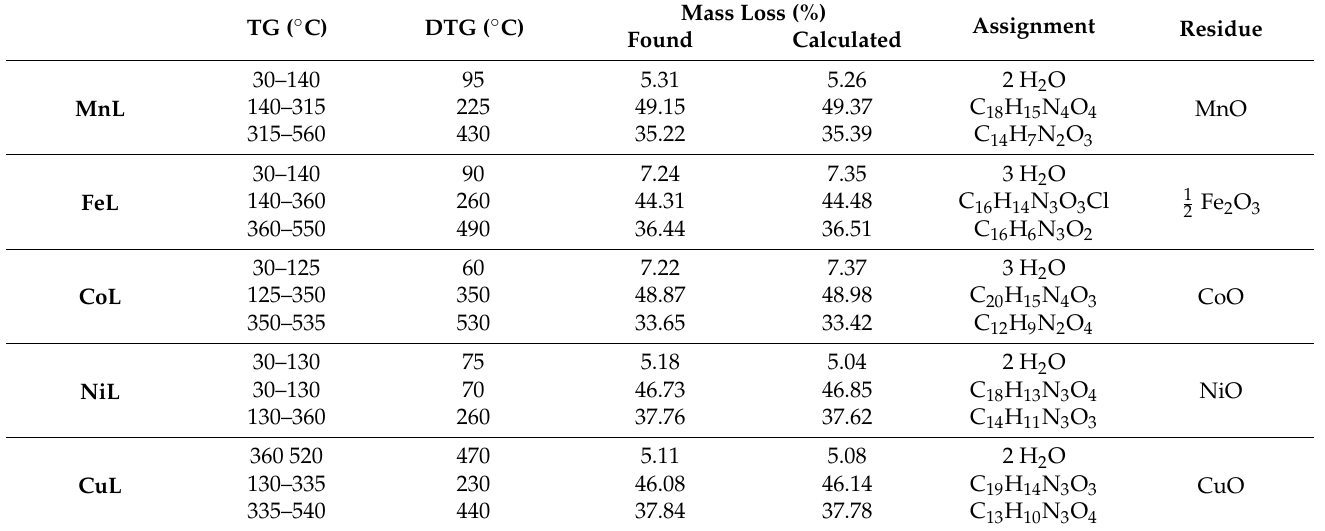
Table 2. Thermal decomposition data.